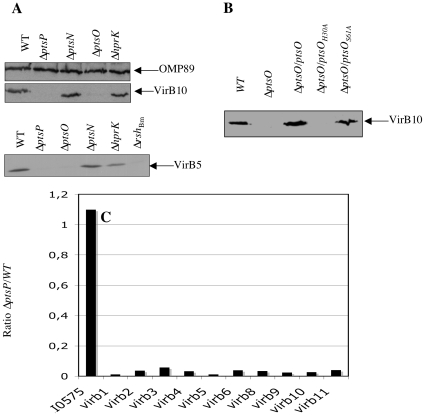
Synthesis of VirB proteins in ΔhprK and Δpts mutants.(A) Detection of VirB10 (top) and VirB5 (bottom) by Western blot analysis in the wild-type (Bm16M), ΔptsP, ΔptsO, ΔptsN and ΔhprK strains following growth in 2YT to late-exponential phase. An established negative control (ΔrshBm) was included in the anti-VirB5 Western blot analysis [46] (B) Western blot analysis of VirB10 with Bm16M (+pMR10cat), ΔptsO (+pMR10cat) and the complemented strain ΔptsO/ptsO, ΔptsO/ptsOH30A, and ΔptsO/ptsOS61A. Identical results were obtained in a second independent experiment. (C) Transcription analysis of virB gene expression in wild-type and ptsP mutant. The values presented by the bars correspond to the ratio of normalized and averaged microarray data (n = 2×3) obtained for 10 virB ORFs in the ptsP mutant and the wild-type strain grown under the same conditions. BMEI0575 is a control ORF whose expression is not modulated whatever the strain considered.